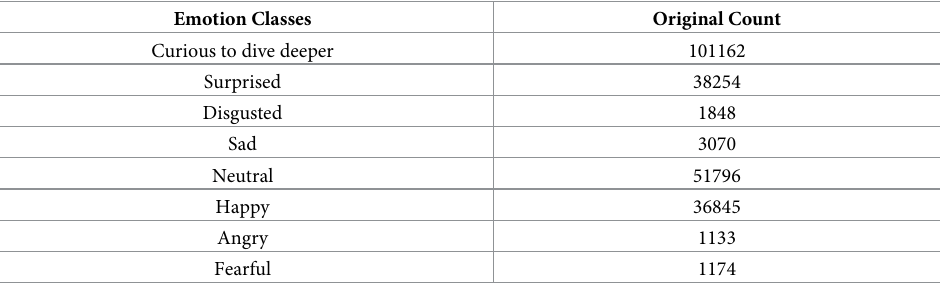
Table 2. Distribution of emotion classes in topical chat